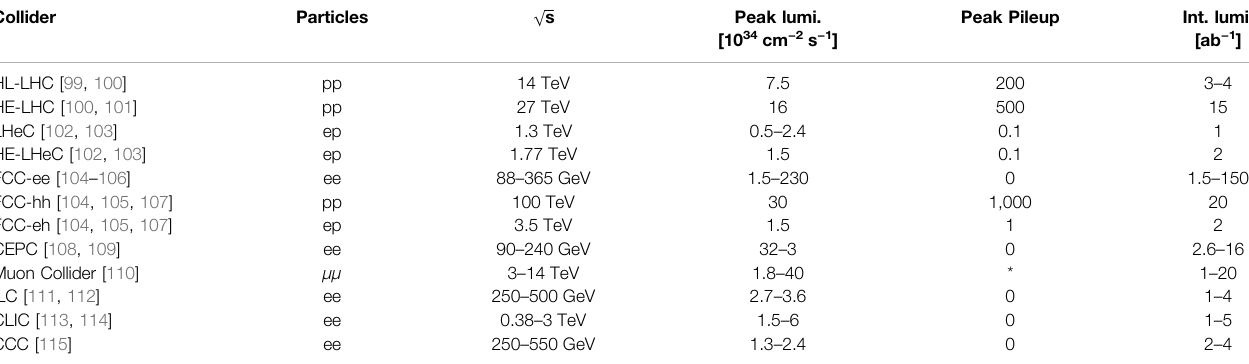
TABLE1| Theparametersofvariousfutureaccelerators.*Muoncollidersfacebeam-inducedbackgrounds,whichhavedifferentpropertiesfrompileupateeorppcolliders. Collider